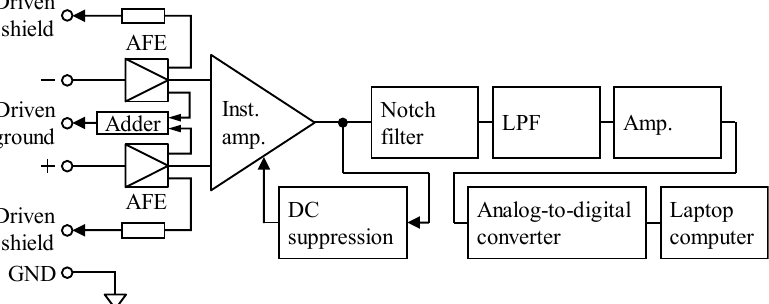
Figure 4. Schematic diagram of the measuring system for both cECG and cEMG. Total gain including AFE was set to 60 dB according to the type of AFE. The frequency bands achieved by a combination of DC suppression and low-pass filter (LPF) were set to 0.5–100 Hz for cECG measurement and to 20–500 Hz for cEMG measurement, respectively. The analog signal was digitized at 1000 Hz with 16-bit resolution between − 10 and + 10 V by the analog-to-digital converter.